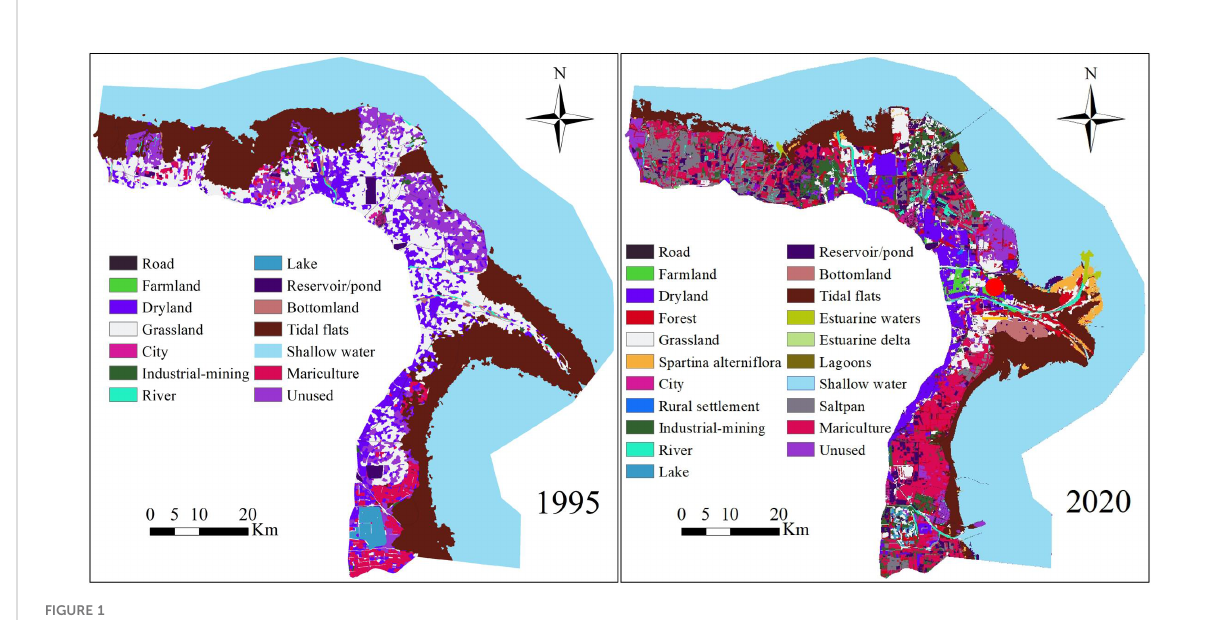
FIGURE 1 Study area of Yellow River Delta and its land use types in 1995 and